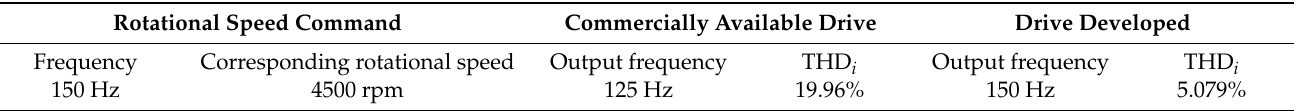
Table 8. Comparison with the output current THD i of two types of drives.